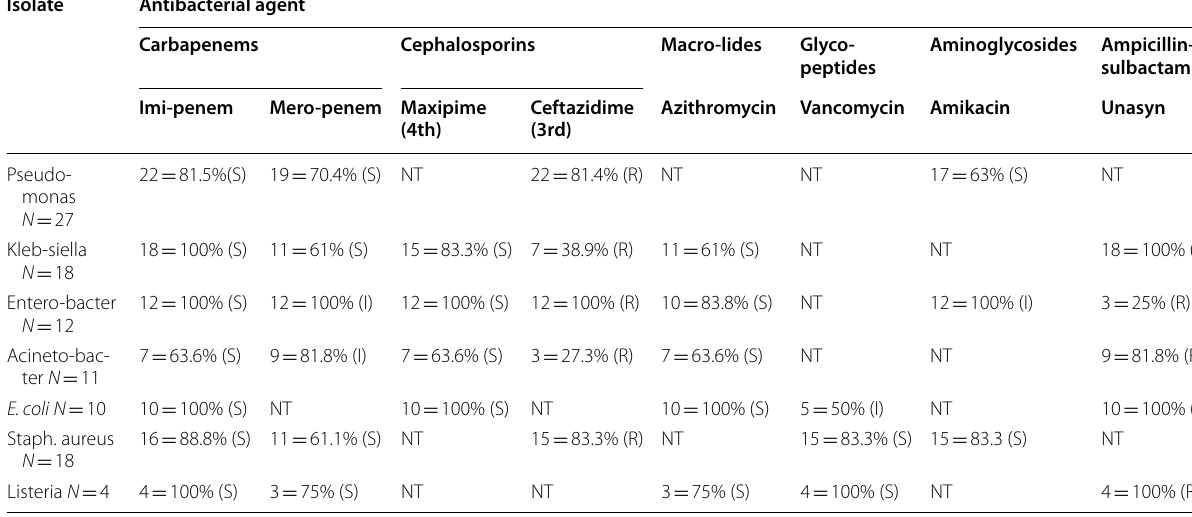
(S)sensitive/(I)intermediate sensitivity/(R)resistant/NS: not tested